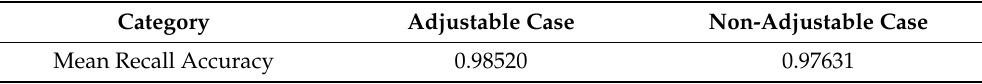
Table 3. The results of classification with adjustable case and non-adjustable